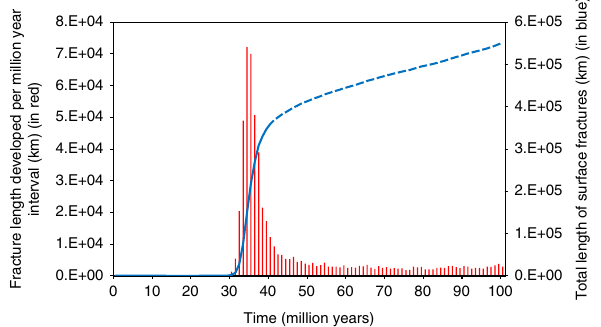
Fig. 2 Fracture development vs time in the reference model. Fracture growth rate per million year interval (red), and the integrated length of all fractures (blue), as a function of loading steps in time. Dashed line indicates evolution beyond the thermal expansion limit after 40 Myr (see text).